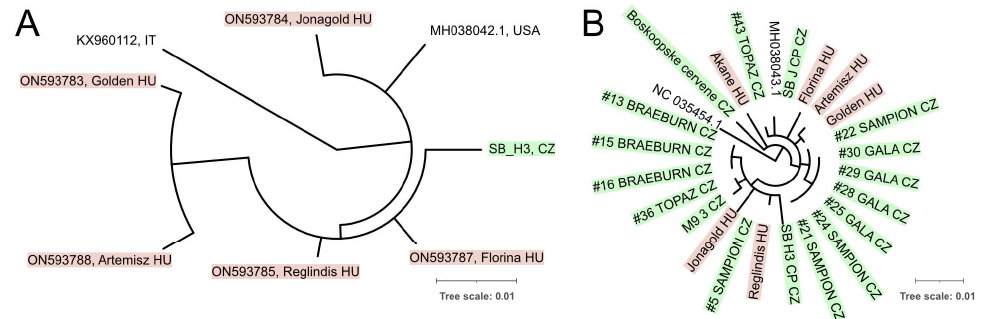
Figure 8. Phylogenetic inference of CCGaV isolates based on portions of RNA1 ( A ) and RNA2 ( B ). Czech and Hungarian isolates are highlighted. All branches with support less than 0.8 were